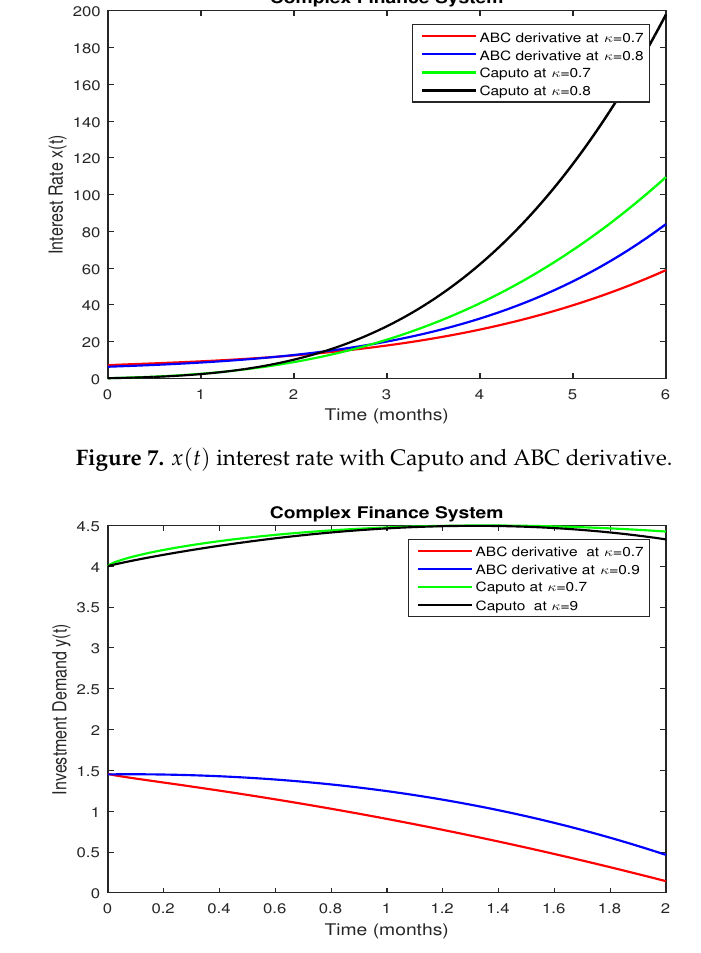
Figure 8. y ( t ) investment demand with Caputo and ABC derivative.